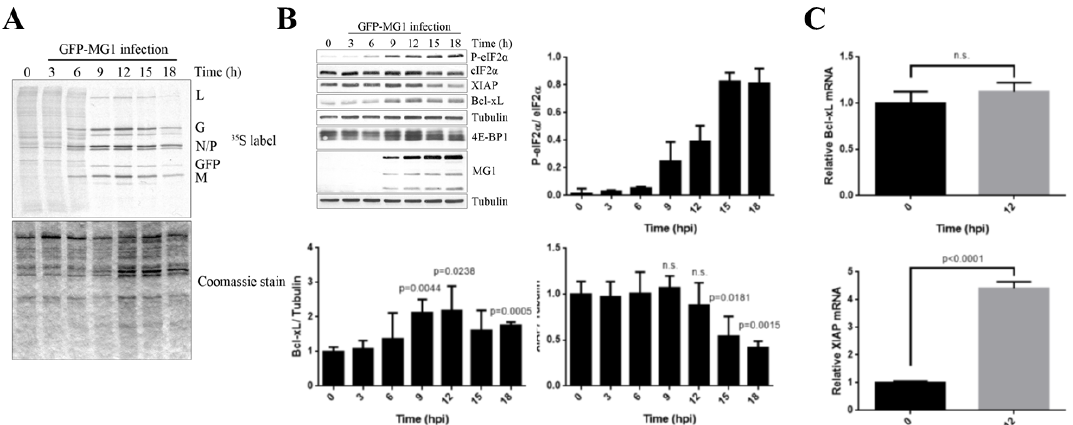
Figure 2. The impact of MG1 infection on the host protein synthesis. ( A ) U2OS cells were infected with MG1 at MOI = 0.1 for 18-h time course. The cells were pulsed labeled with [ 35 S]-methionine for 20 min. Next, the obtained lysates were separated through 10% SDS-PAGE electrophoresis. Identity of viral proteins is indicated to the right of the image; Coomassie blue staining demonstrates the protein loading. ( B ) Western blot of U2OS cells infected with MG1 at MOI = 0.1 during an 18-h time course demonstrated phosphorylation of eIF2 α , de-phosphorylation of 4E-BP1 and up-regulation of Bcl-xL protein. The levels of Bcl-xL and XIAP proteins were quantified relative to Tubulin used as a loading control. ( C ) Steady-state levels of Bcl-xL and XIAP mRNAs were determined in mock- and MG1-infected cells at 12 hpi. Ct values were normalized by the standard curve of each primer and represented relative to the geometric mean of RPL13A and RPL36. (n.s. = not significant)